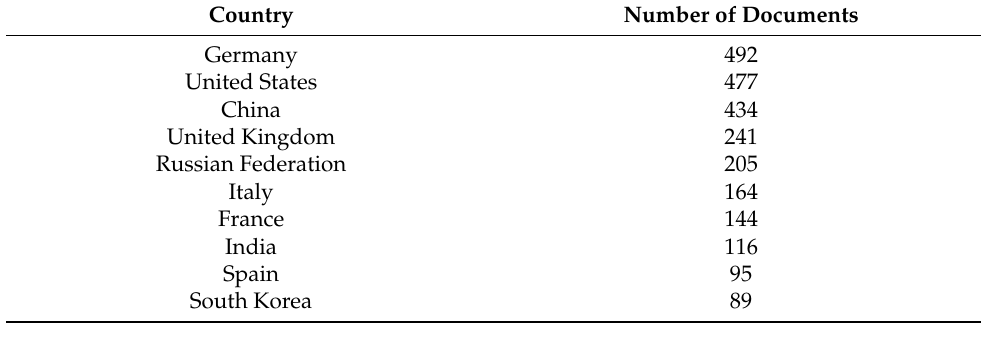
Figure 5. Annual publication trend of 3301 documents retrieved from Scopus for the DT research field in the period 2003–2021. Table 1. Top ten affiliated countries publishing on DTs.